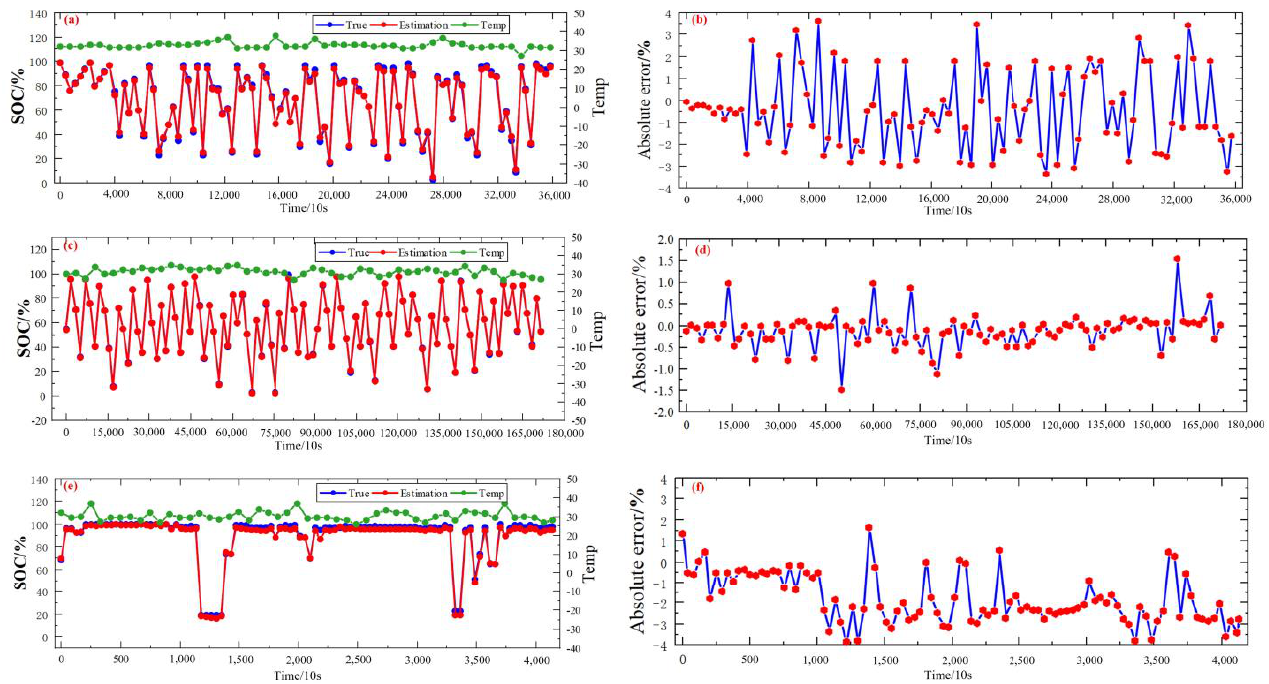
Figure 8. SOC estimation results and absolute errors under three different working conditions. ( a )